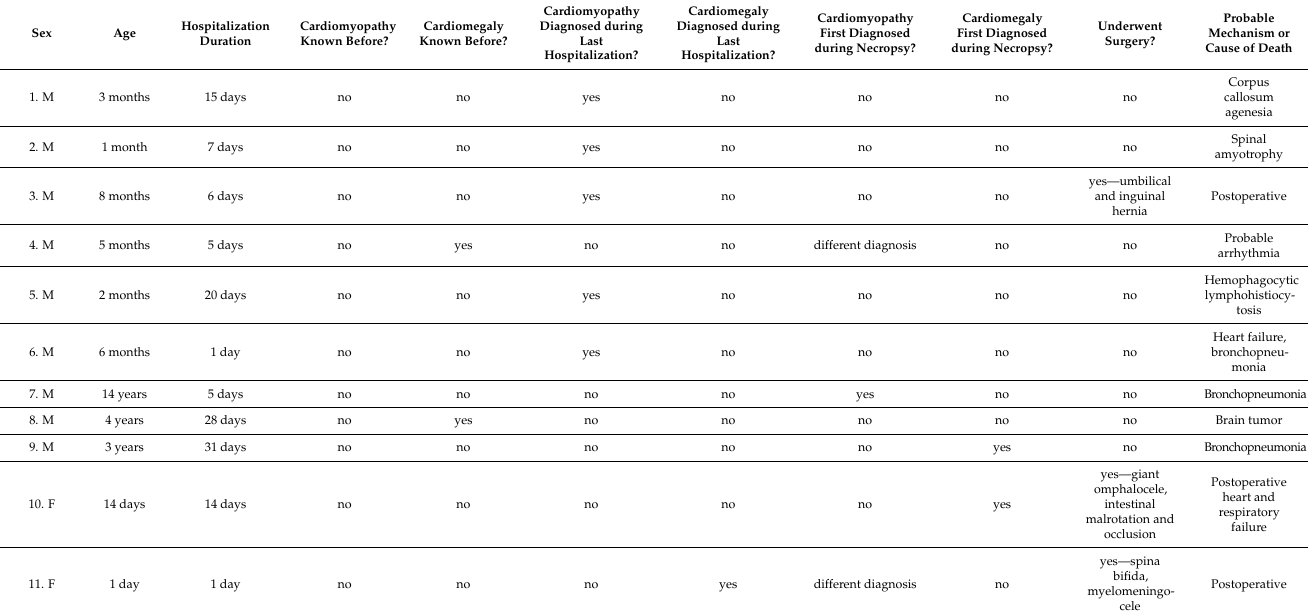
Table 1. Patient